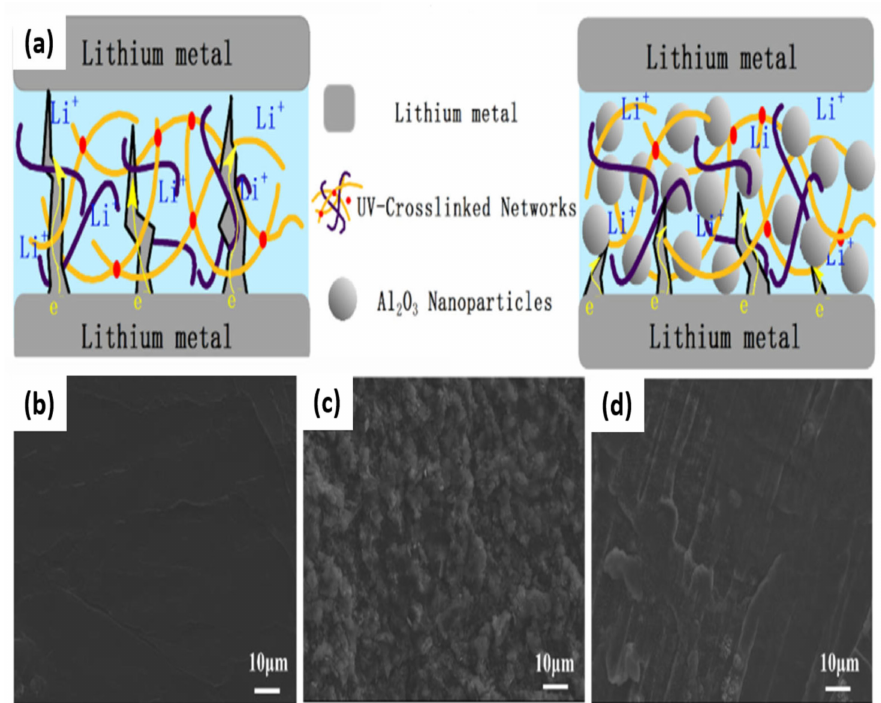
Figure 18. ( a ) Schematic illustrations the prevent of lithium dendrite growth by Al 2 O 3 -GPE elec- trolyte; ( b ) pristine of lithium anode before cycling in LFP/GPE/Li cell; ( c ) lithium anode in LFP/GPE/Li cell after 200 cycles at 0.5 C; ( d ) lithium anode in LFP/Al 2 O 3 -GPE/Li cell after 200 cy- cles at 0.5 C. Reprinted with permission from Liu et al. [143]. Copyright 2018. The Chinese Ceramic Society. Production and hosting by Elsevier